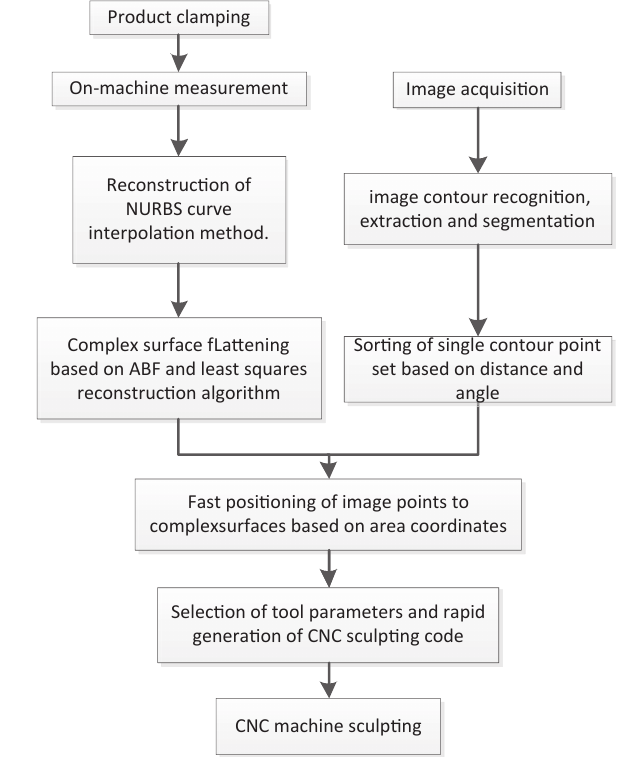
Figure 1. The flow chart of the proposed method of adaptive NC